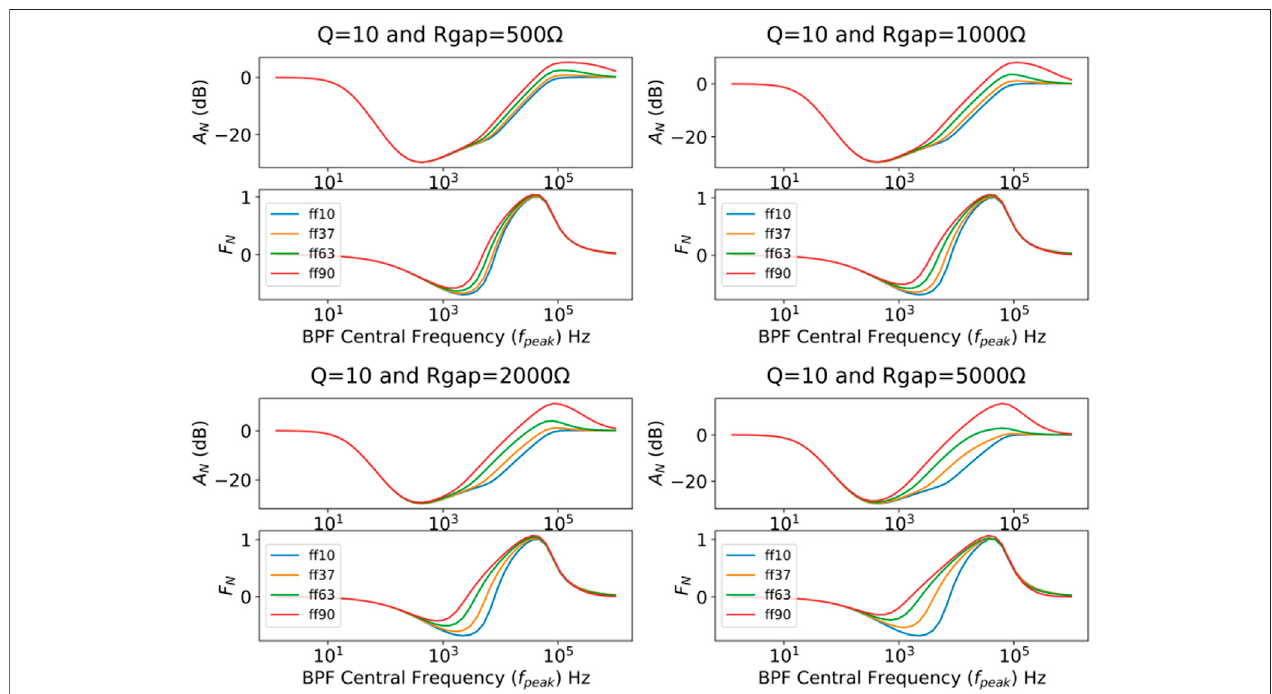
FIGURE 6 | Oscillation Based Spectroscopy (OBS) normalized response for different values of R gap , and Q f (cid:2) 10. The simulations are performed over different fi ll factor levels (10%, 37%, 63%, and 90%).